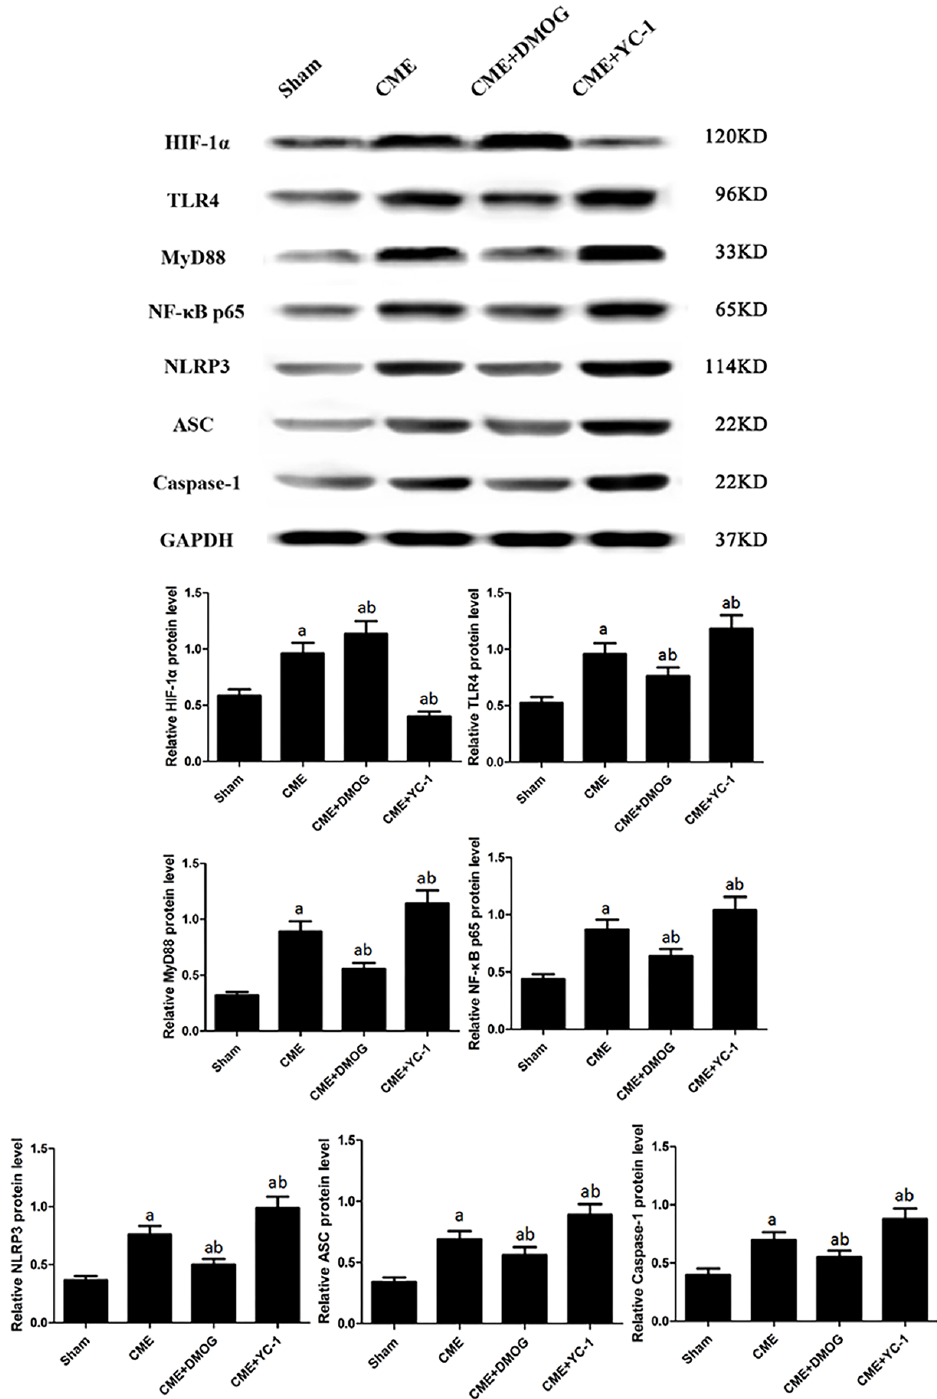
Figure 4 . Effects of HIF-1α on TLR4/MyD88/NF-κB signaling and NLRP3 inflammasome pathway. HIF-1α expression was decreased, and the expression of TLR4, MyD88, NF- κB p65, NLRP3, ASC and Caspase-1 was increased following coronary microembolization (CME). DMOG reversed the expression of CME on the expression of these proteins, whereas YC-1 aggravates these effects. a P <0.05 in comparison to sham group; b P <0.05 in comparison to CME group. n =